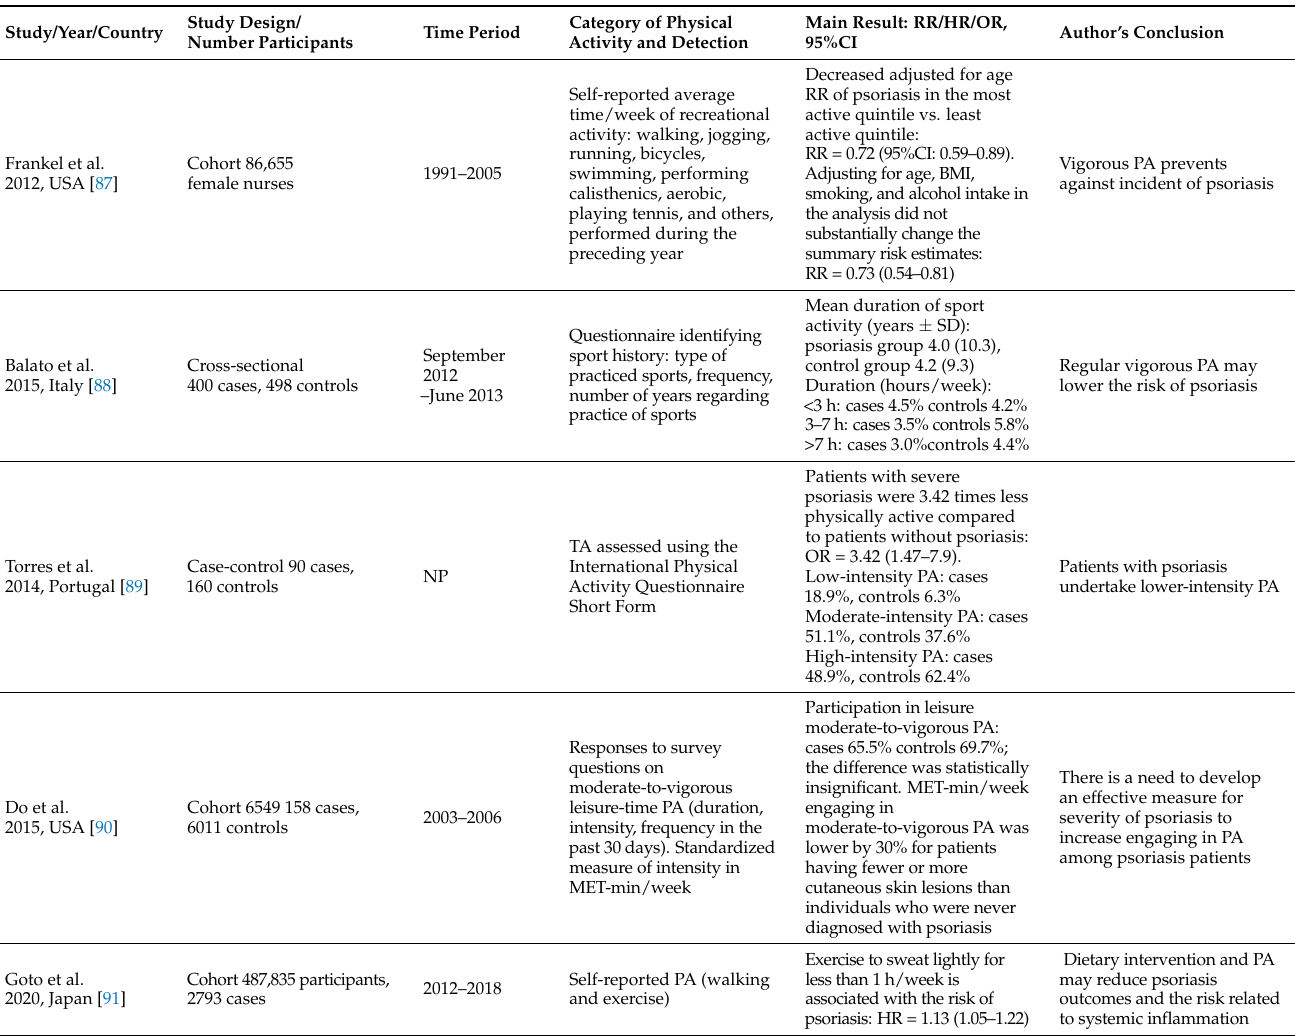
Table 1. The representative observational studies for the association between psoriasis and physical